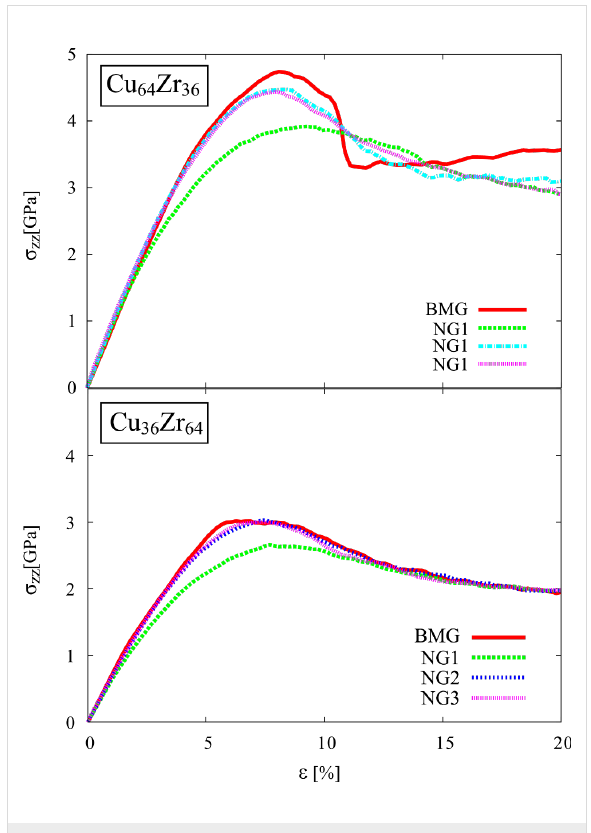
Figure 4: Tensile stress–strain curves for Cu 64 Zr 36 and Cu 36 Zr 64 BMGs and as-prepared (NG1), annealed (NG2), annealed and pre- deformed (NG3) NGs with the same chemical composition and a grain size of 10 nm, at a constant strain rate of 4 · 10 7 s − 1 .